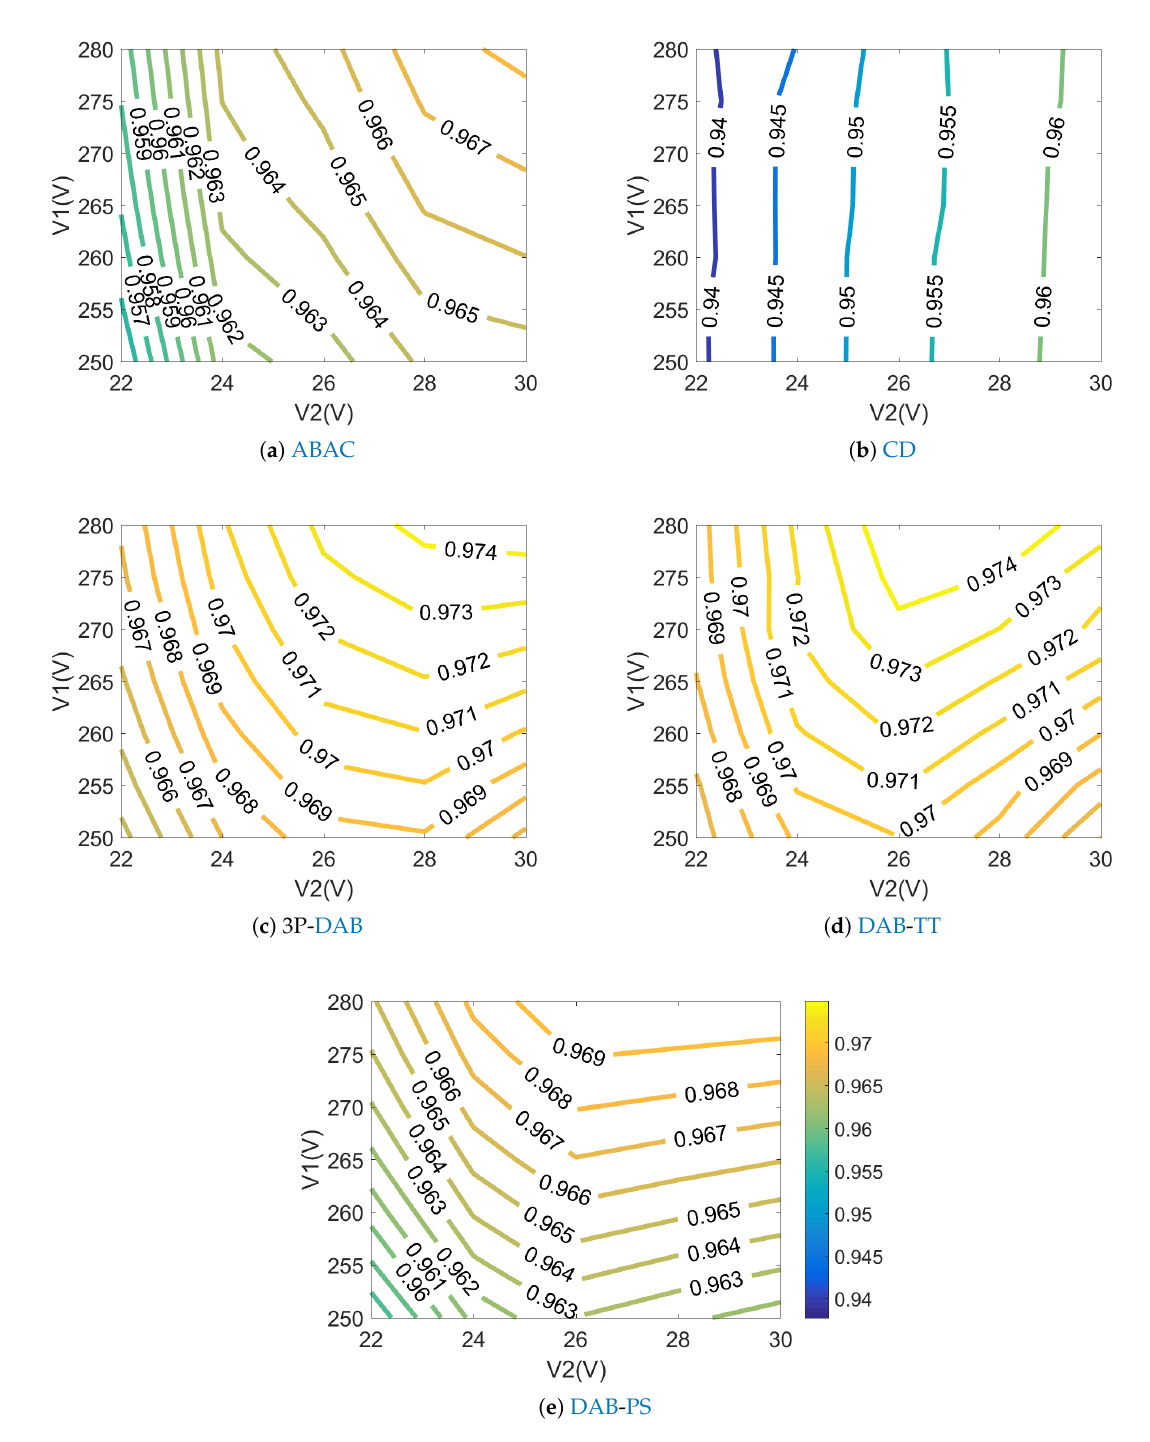
Figure 7. Full power efficiency maps in buck